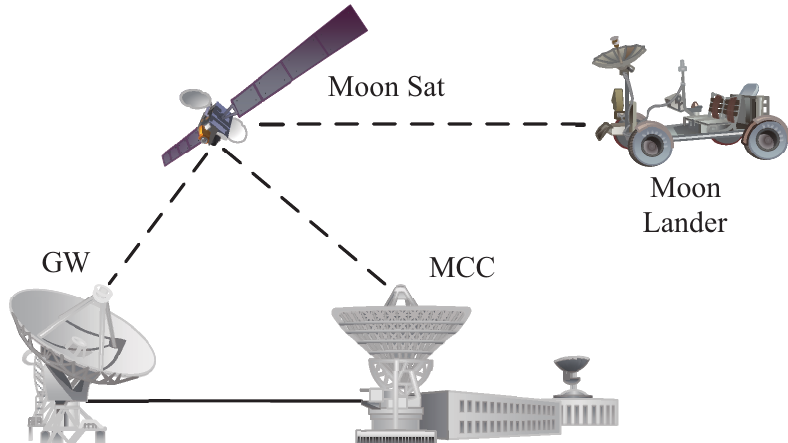
Figure 12. Experimental scenario.